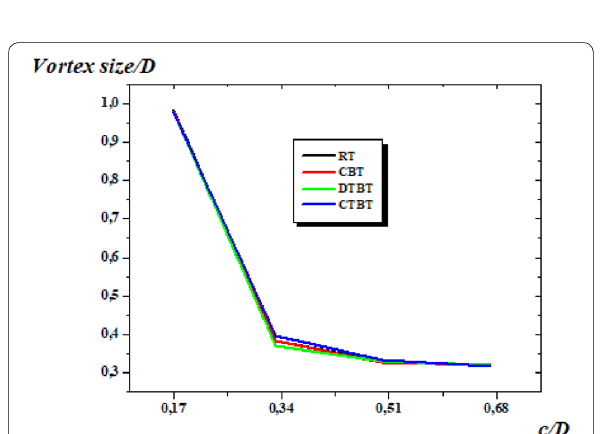
Figure 25 Vortex size versus the impeller clearance ratio for different agitator’s types, Re